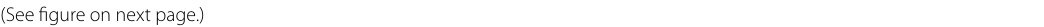
Fig. 2 By performing GO enrichment analysis on DEGs, we obtain the circle maps of cell component, biological process, and molecular function. a The enriched cell component suggests changes in the composition of cell miosis component. b The enriched biological process suggests activation of G protein-coupled receptor-related signaling pathways and changes in ion transport. c The enriched molecular function suggested the involvement of various proteins and factors involved in the regulation of immune response,